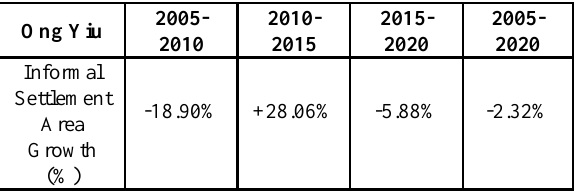
Table 9. Informal Settlement Growth in Percentage in Brgy. Ong Yiu